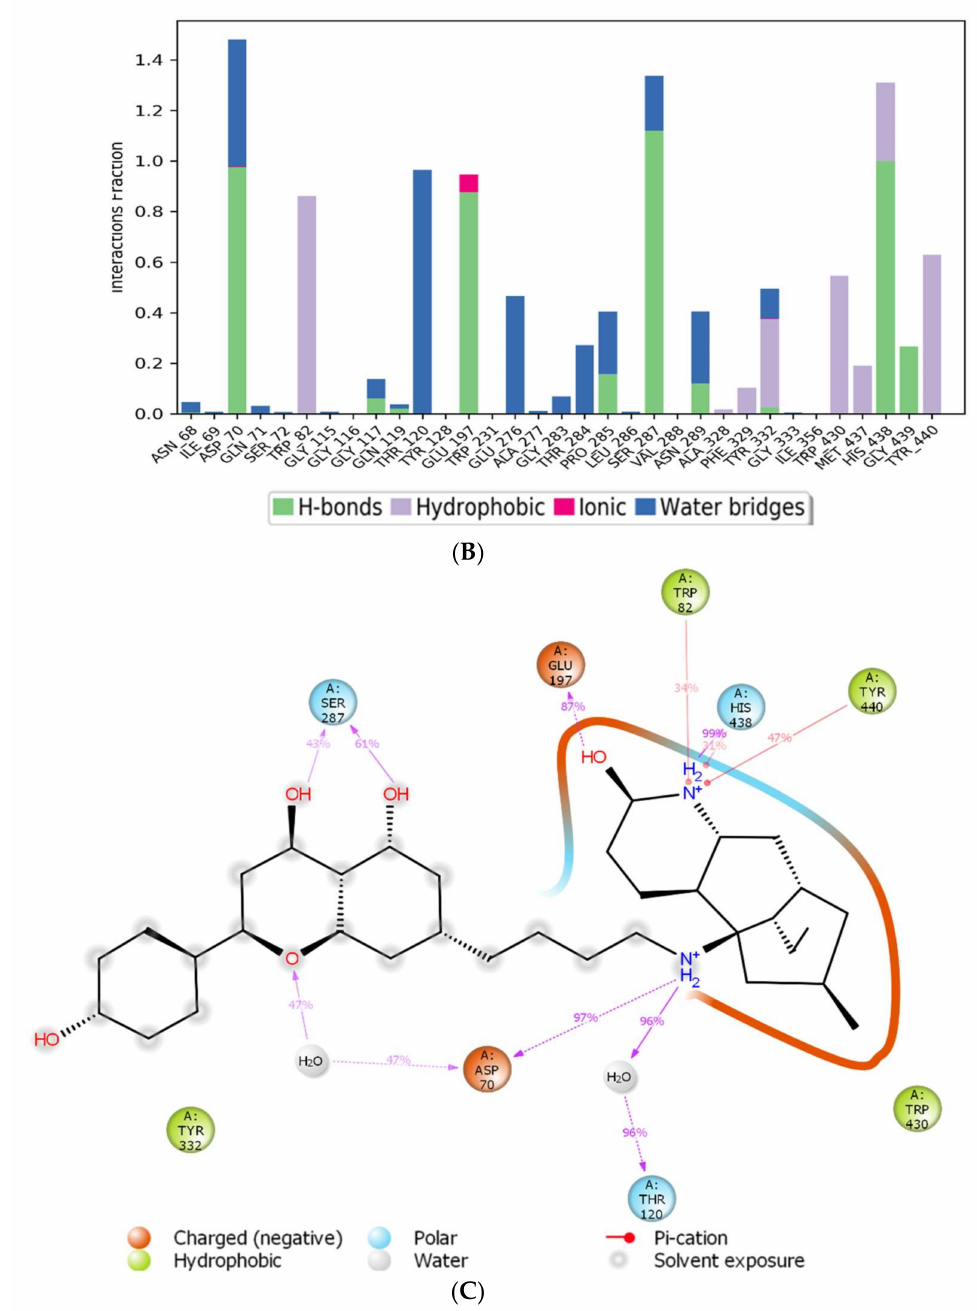
Figure 5. MD simulation studies of huperzine-4C-naranginin in complex with BuChE. ( A ) RMSD plot of protein backbone (C α ) and protein conformational change during ligand binding. ( B ) Interaction fraction plot showing different protein residues that interact with the ligand during a 50 ns MD simulation. ( C ) Interaction of ligand atoms with the protein residues that occur for more than 30% of the simulation